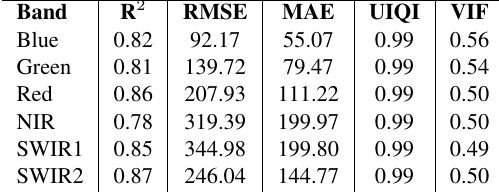
Table 2: Validation agreement of Maxwell et al. (2007) mul- tiscale segmentation gap-filling method on bands Blue, Green, Red, NIR, SWIR 1 and SWIR 2, obtained by simulating SLC-off effect using Landsat-8/OLI images.